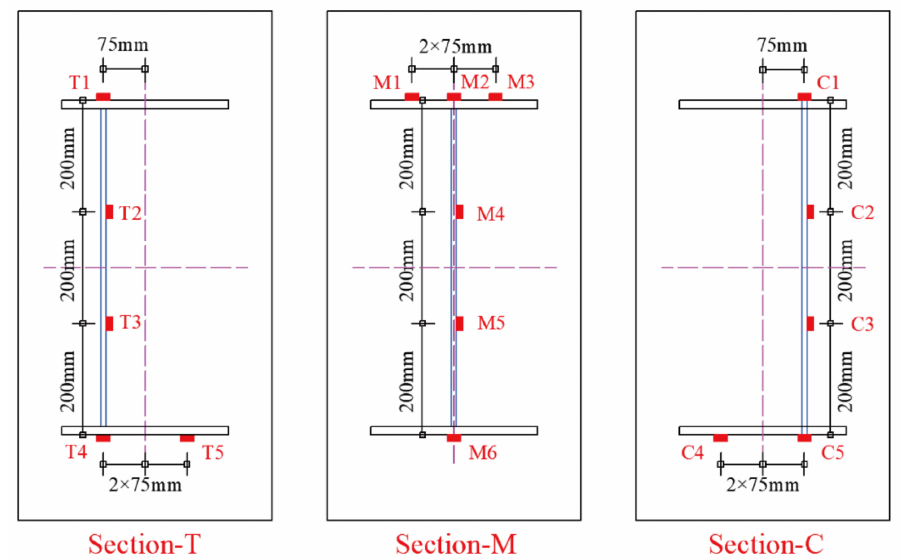
Figure 3. The detailed locations and serial numbers of thermometers.